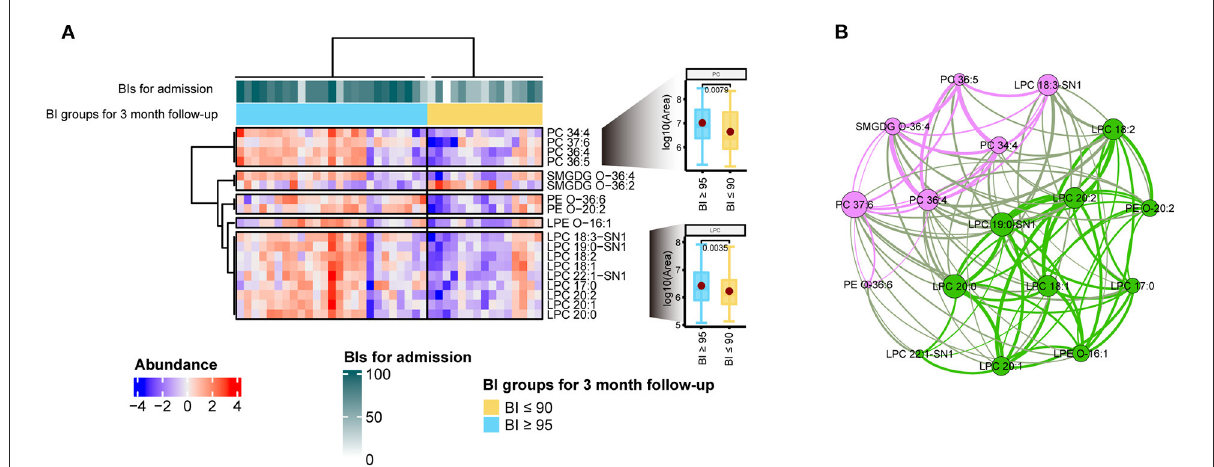
FIGURE4 Indicators for stroke rehabilitation. (A) Heatmap of the 18 significantly changed lipid features associated with stroke rehabilitation. All features were split into five groups by lipid species. Two box plots provided the comparisons between good and poor recovery groups for LPC and PC species, respectively. The annotations for each individual were displayed as three-colored tracks on top of the heatmap. Z -score normalization was used to compare the lipid abundance over samples. (B) Correlation-based lipid network. Each node represents a lipid feature, and the edge represents the correlation between lipids. All pairwise correlation values for each node were calculated under the R environment. Two modularity classes were identified by the Louvain method of community detection and coded by the pink and green colors in the network, respectively. The importance or essentiality of a lipid node in the network is determined by its betweenness score. A node with a larger size indicates a higher betweenness